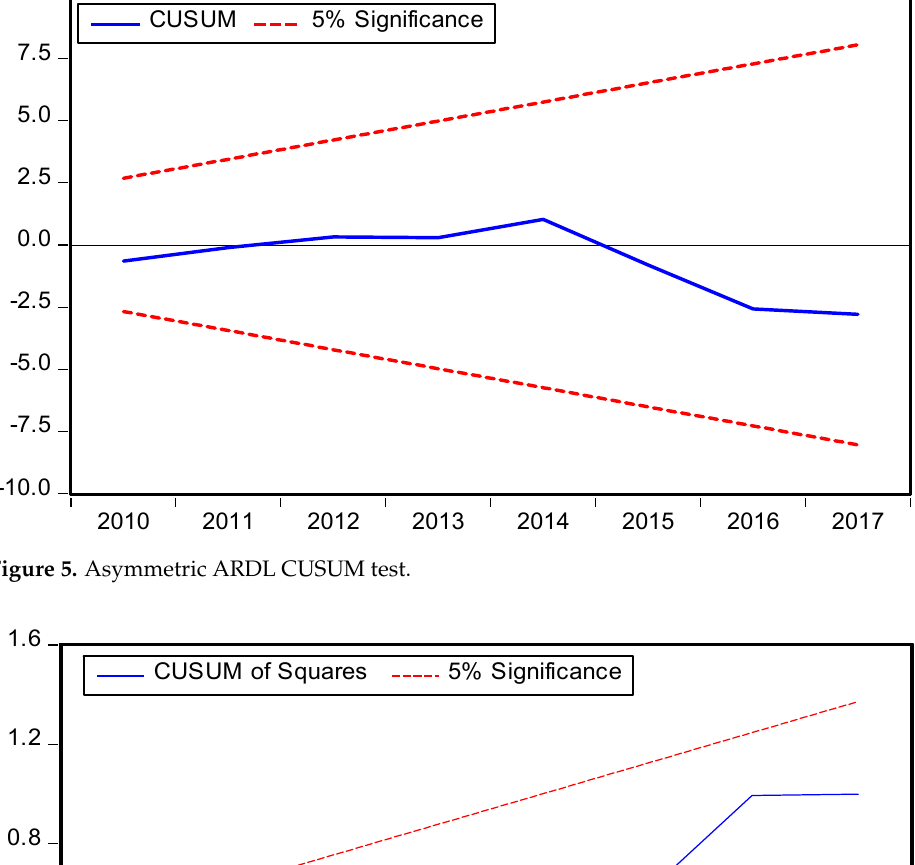
Figure 5. Asymmetric ARDL CUSUM test.